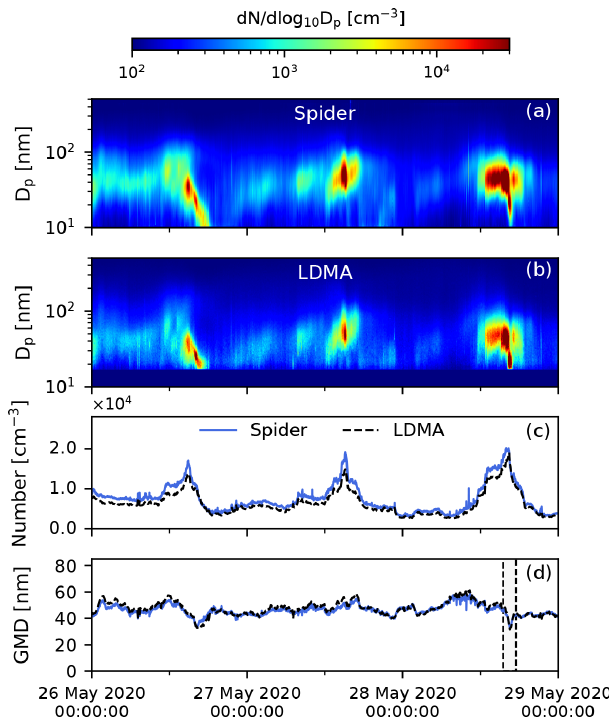
Figure 6. Evolution of the particle size distribution over a period of 3d measured by (a) the Spider DMA and (b) the LDMA system. Corresponding total particle number and geometric mean diame- ter, calculated over the 17–500nm size range, are shown in pan- els (c) and (d) , respectively. Solid blue color in panel (b) (size range < 17nm) was used for no available data in the LDMA system. The dashed box in panel (d) indicates the time period shown in Fig.